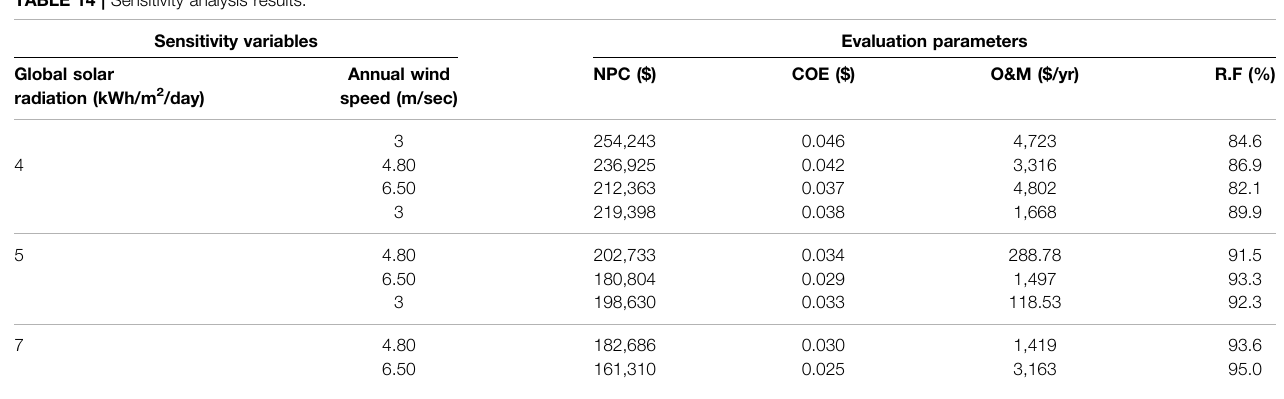
TABLE 14 | Sensitivity analysis